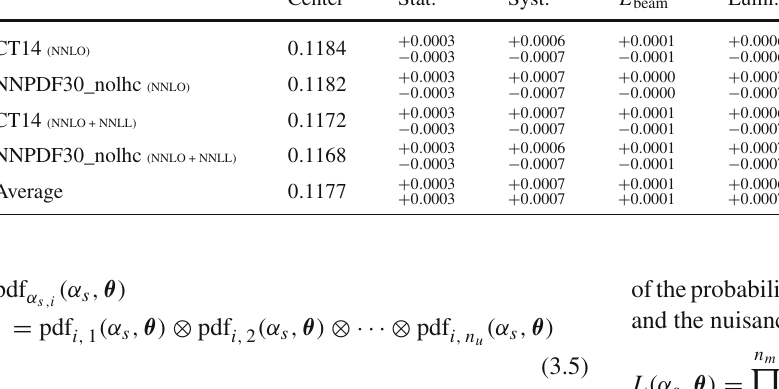
Table 9 Combination results for all PDF sets taken into consideration, at NNLO and NNLO + NNLL Center Stat. Syst. E beam Lumi. m